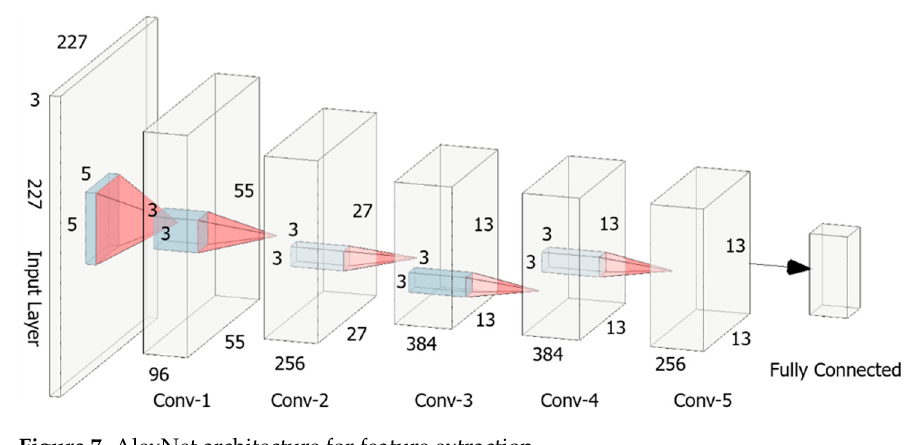
Figure 7. AlexNet architecture for feature extraction.